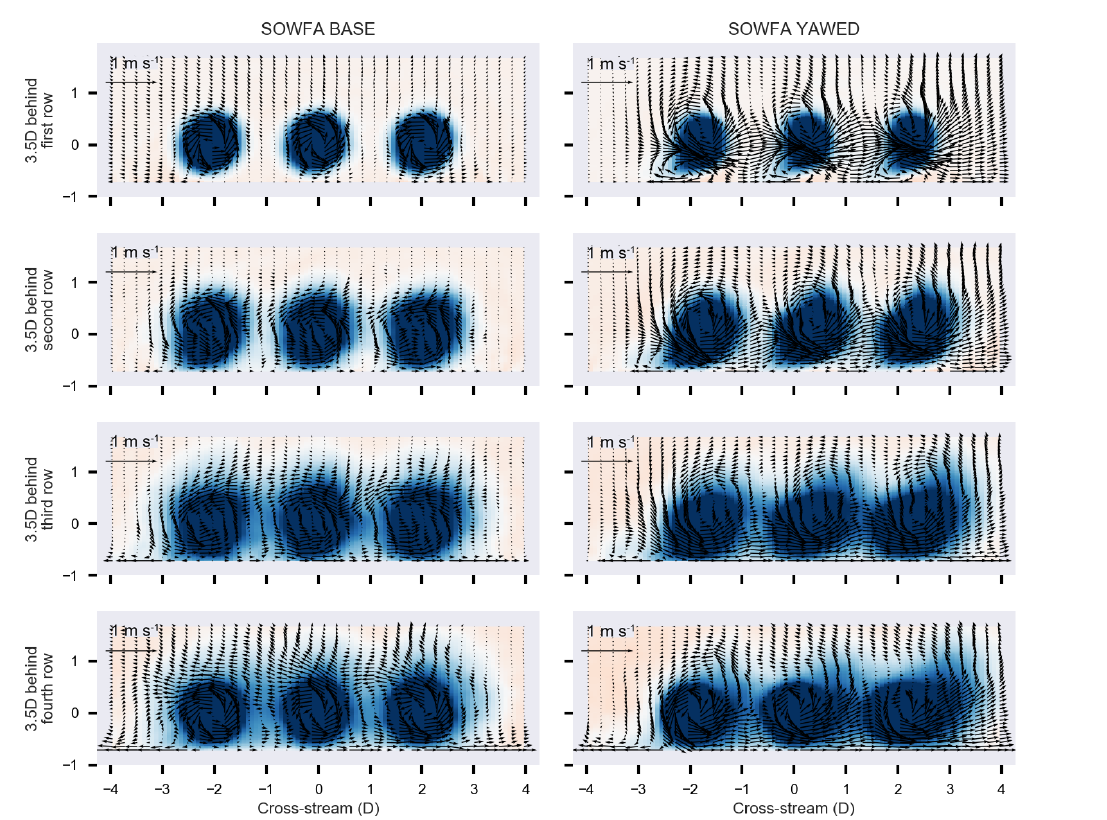
Figure 13. Cut-through visualizations of SOWFA following each row in the turbine array scenario “yawAll”.